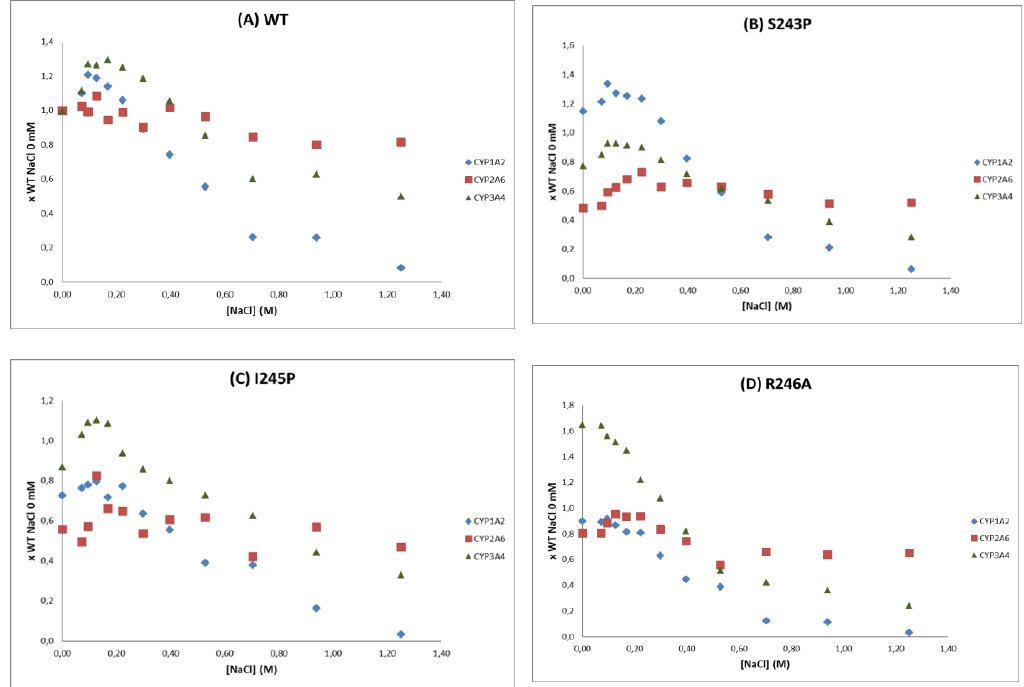
Figure 2. CYP reaction velocity ( k obs ) in function of the NaCl concentration, for the WT and mutant forms of CPR with CYP1A2 ( A ), CYP2A6 ( B ) or CYP3A4 ( C ).